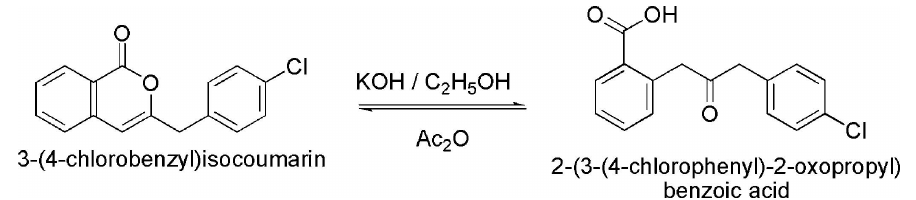
Figure 3 The formation of the title